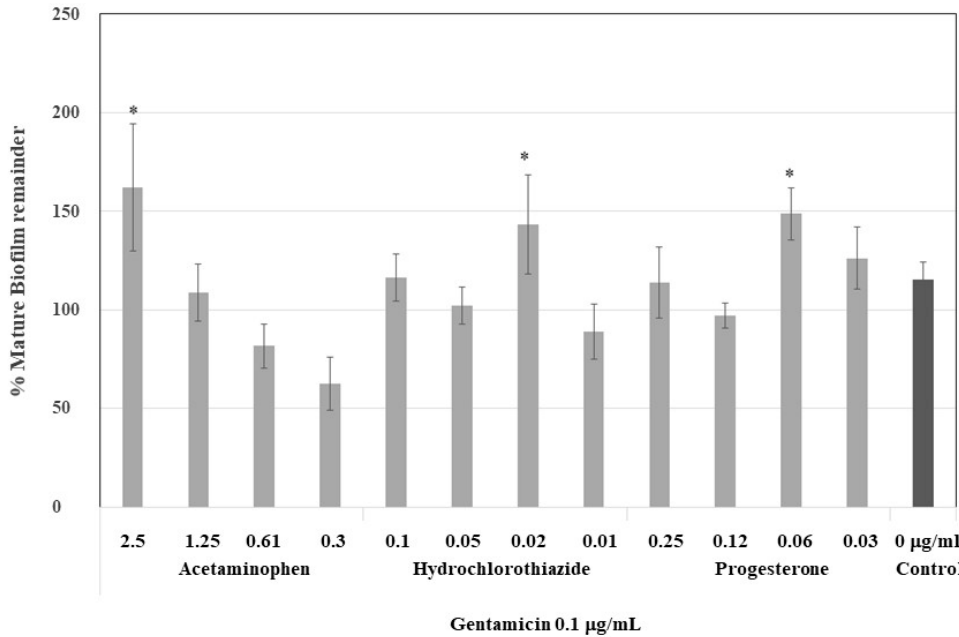
Figure 4. Effect of gentamicin on the stability of the biofilm formed under biofilm-inducing drugs at plasmatic concentrations. Mature biofilm formed after 30 h of drug applications was treated with gentamicin 0.1 µg/mL, and then, the mature biofilm remainder was quantified. In acetaminophen, a drug-dependent decrease was noticed at higher concentrations of 2.5 and 1.25 µg/mL. * Statistically significative difference.